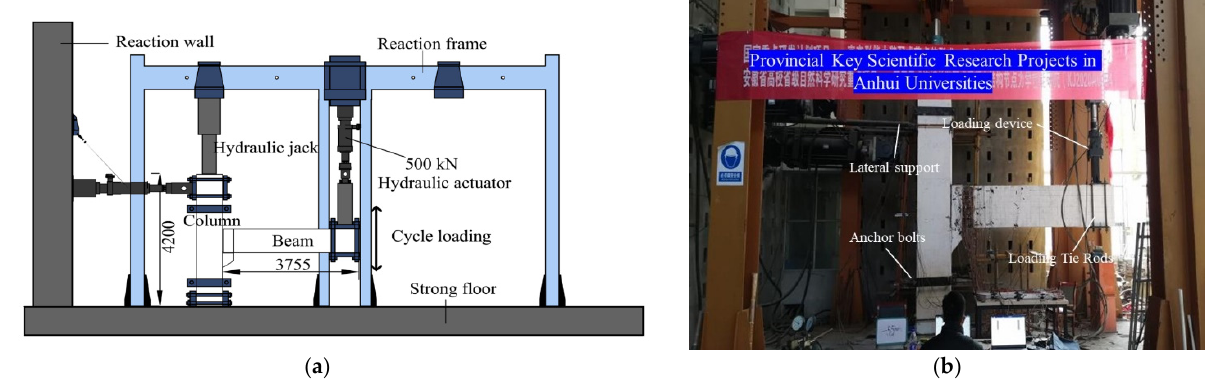
Figure 7. Brace and loading regime of specimens. ( a ) Loading device diagram; ( b ) loading site